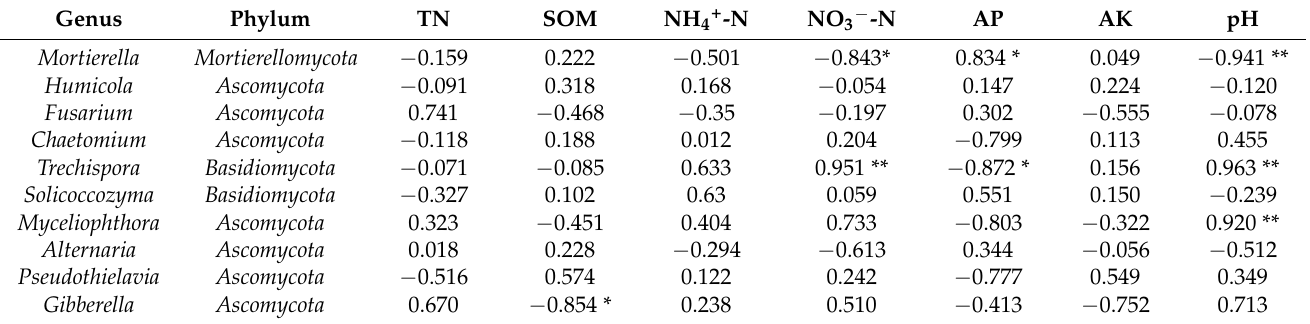
Table 2. The Spearman’s correlations between soil properties and fungal abundance at the genus level.